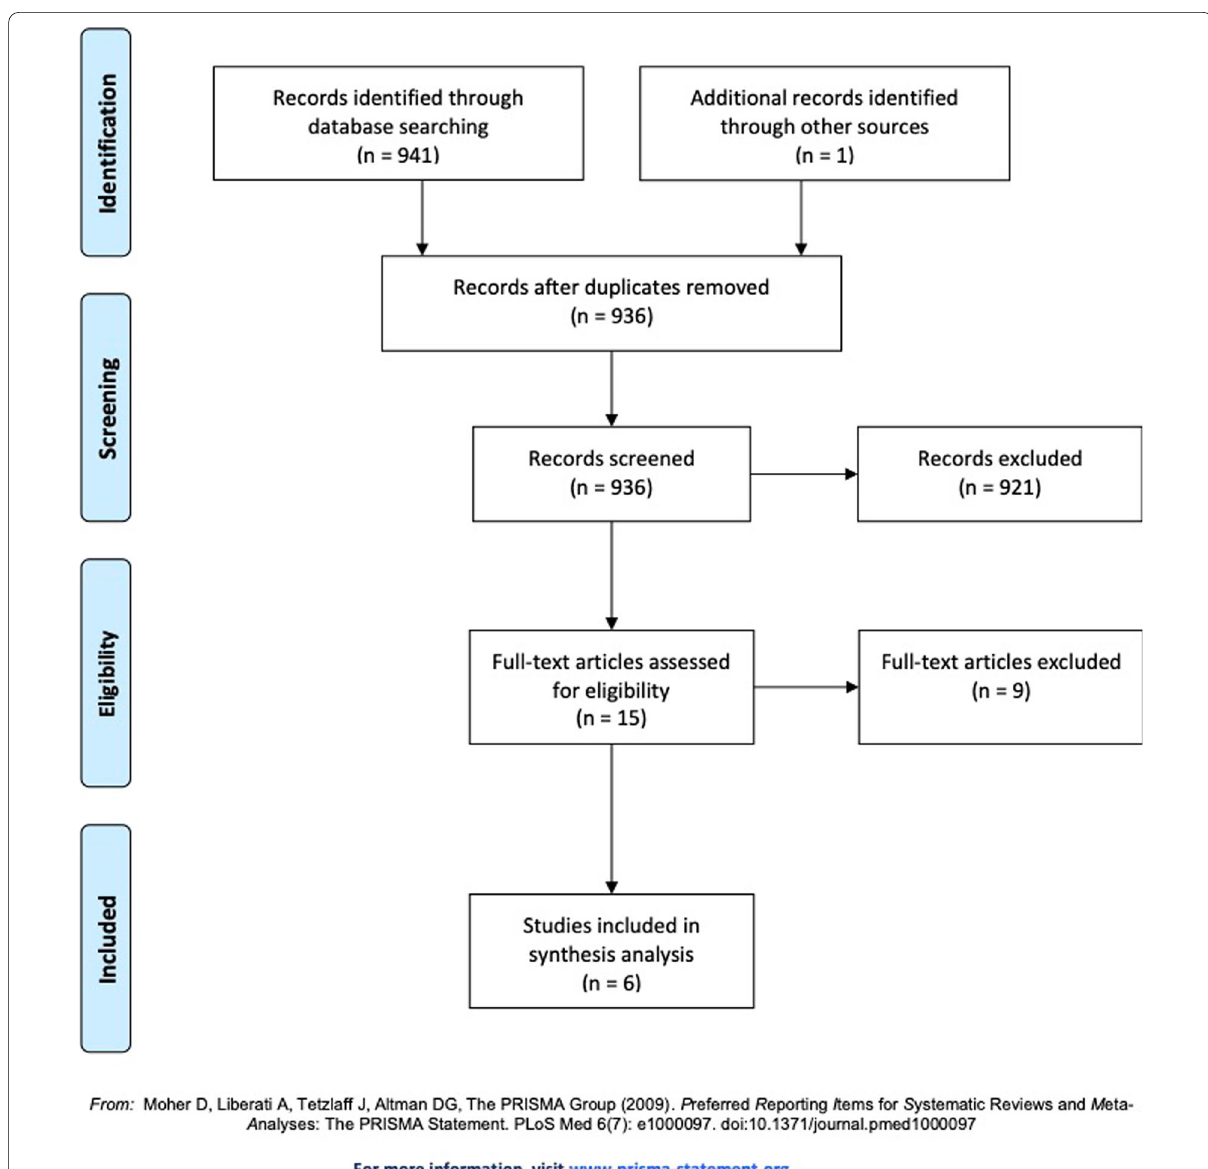
Fig. 1 Flowchart of literature